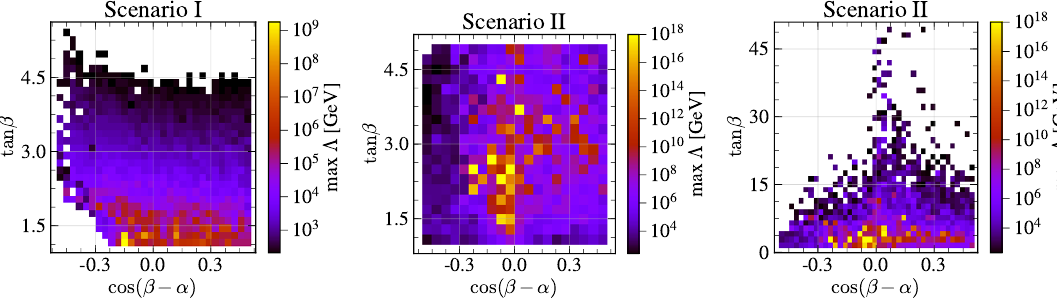
Figure 7 . Maximum breakdown energy as function of tan (cid:12) and cos( (cid:12) (cid:0) (cid:11) ). (Left): scenario I (Middle & Right): scenario II. The middle (cid:12)gure is a zoomed in region of the right one. Note the di(cid:11)erence in scale of the breakdown energy in the two